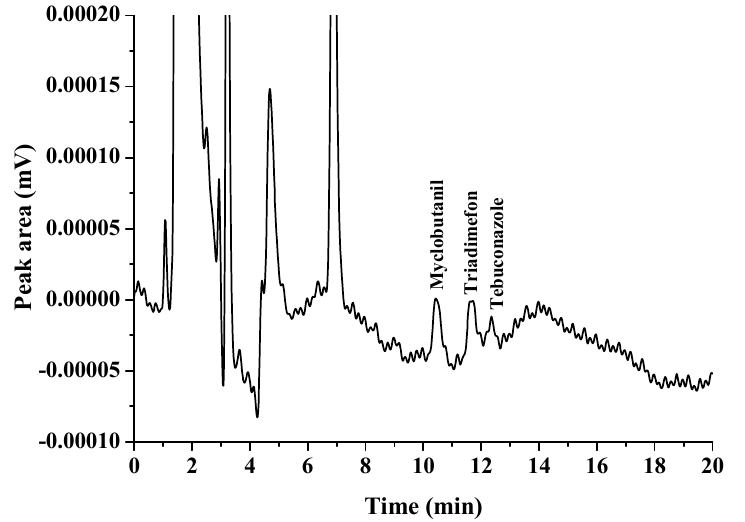
Figure 1. Extraction of triazole fungicides using 1-dodecanol as a solvent.